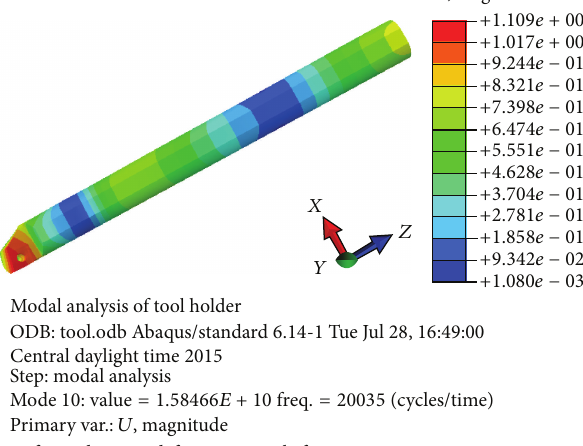
Figure 7: Modal analysis graphic of tool holder with cutting